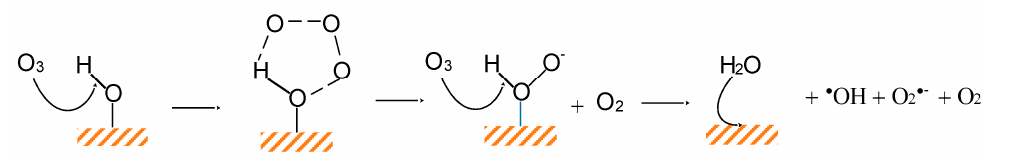
Figure 4. Schematic representation of the ozone reaction with the hydroxyl groups of metal oxide surface [47].